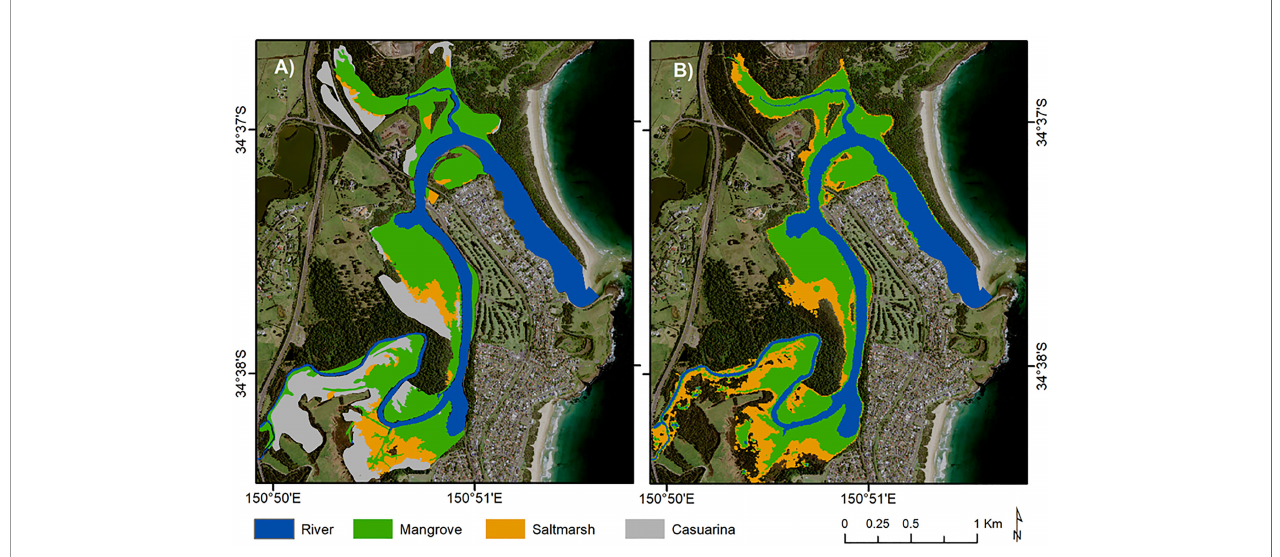
FIGURE 6 | Comparison of wetland vegetation mapping based on Owers et al. (2016) (A) and eco-morphodynamic model predictions of mangrove and saltmarsh distribution (B) based on average inundation durations per event from a 28-day tide simulation for November/December 2019. Note that Casuarina are not included in the